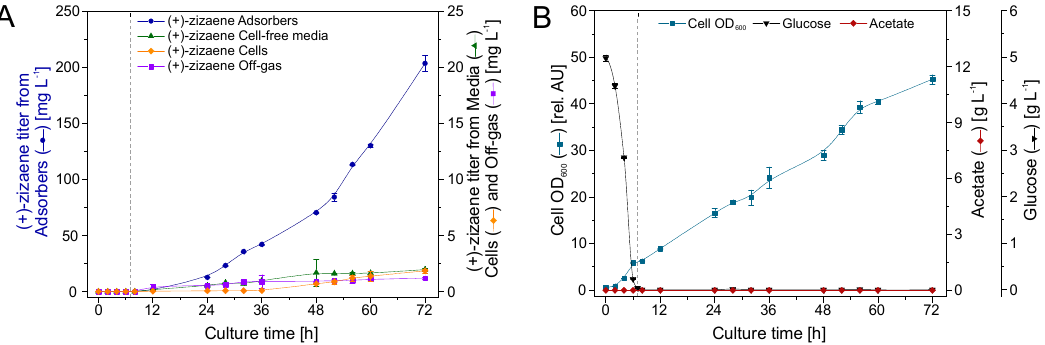
Figure 9. Production of (+)-zizaene ( A ) and growth kinetics ( B ) in 2 L bioreactor with internal recovery configuration with gas stripping (IRC+GS). Dotted line indicates division between batch and fed-batch stages.